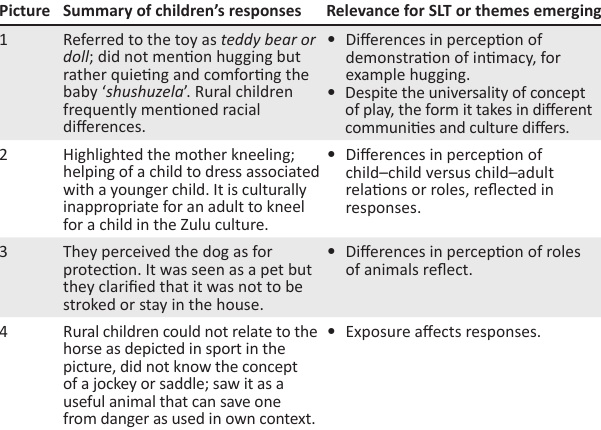
FIGURE 1: Illustrating picture card 8 from the RAPT (1997) ( © Speechmark Ltd). TABLE 3: Some results of the voice of the children for each picture. Picture Summary of children’s responses Relevance for SLT or themes